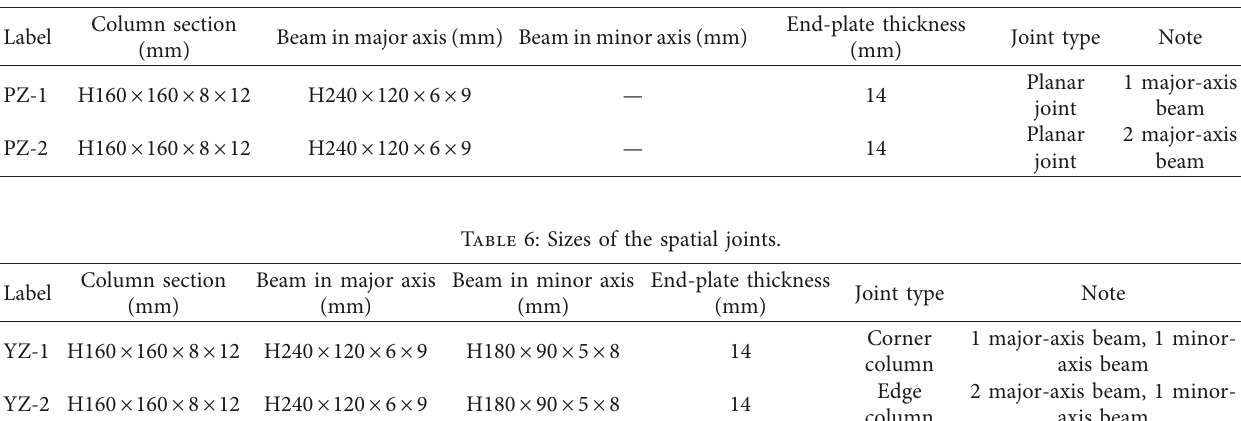
Figure 9: FE models of the spatial joints. (a) YZ-1. (b) YZ-2. (c) YZ-3. Table 5: Sizes of the planar joints.